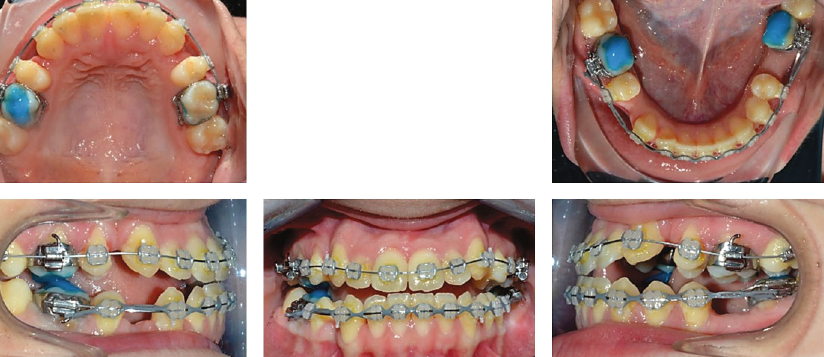
Figure 4: Progress